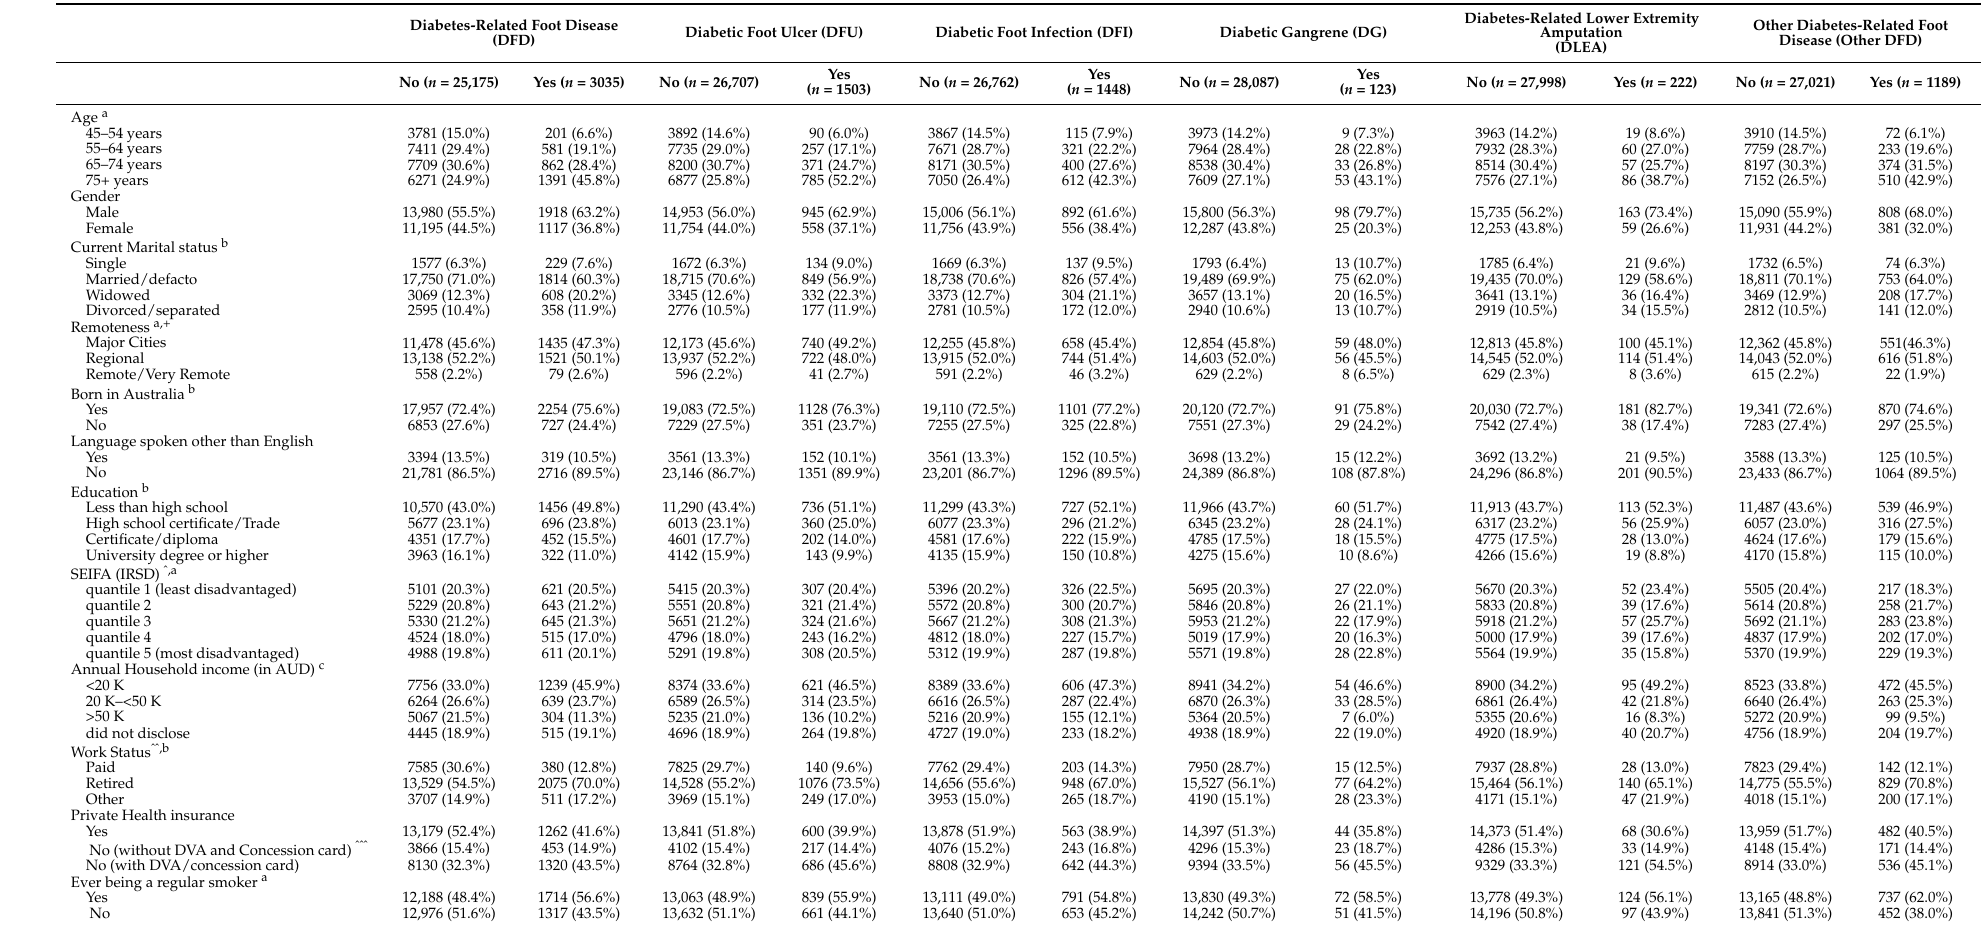
Table A4. Characteristics of survey participants with diabetes ( n = 28,210) according to different diabetic foot